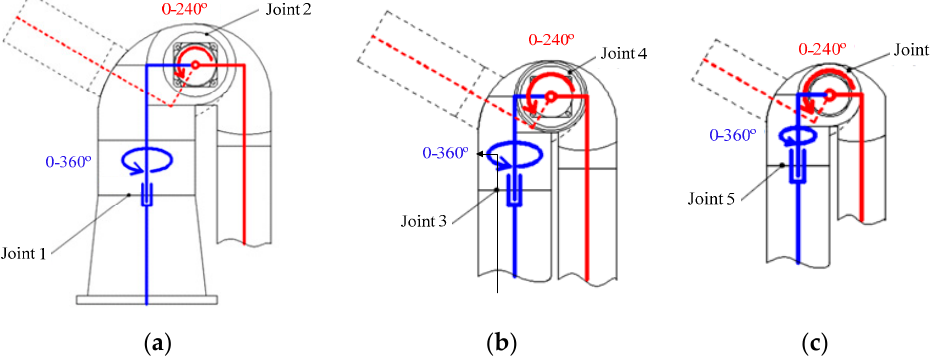
Figure 3. 3D model of the self-driven AACMM.